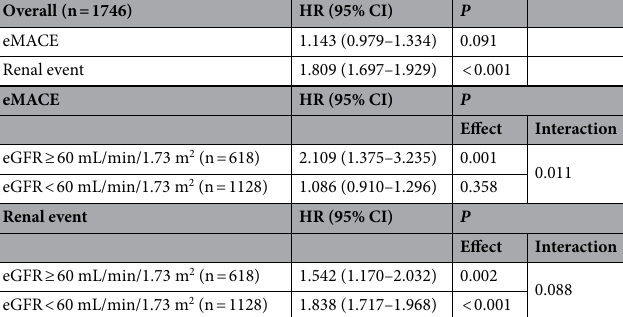
Table 3. Adjusted hazard ratios of per SD-unit increase in urine protein-creatinine ratio (UPCR) for extended major adverse cardiovascular events (eMACEs) and renal events. HR hazards ratio, CI confidence interval, UPCR urine protein-creatinine ratio, eMACE extended major adverse cardiovascular events. *Adjusted for age, sex, BMI, smoking, previous CVD, diabetes, hypertension, glomerulonephritis, baseline eGFR, and use of RAS blocker and